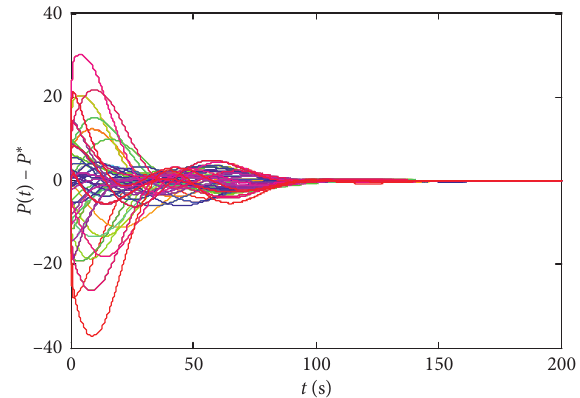
Figure 5: The response curves of the tracking error matrix P − P ∗ .